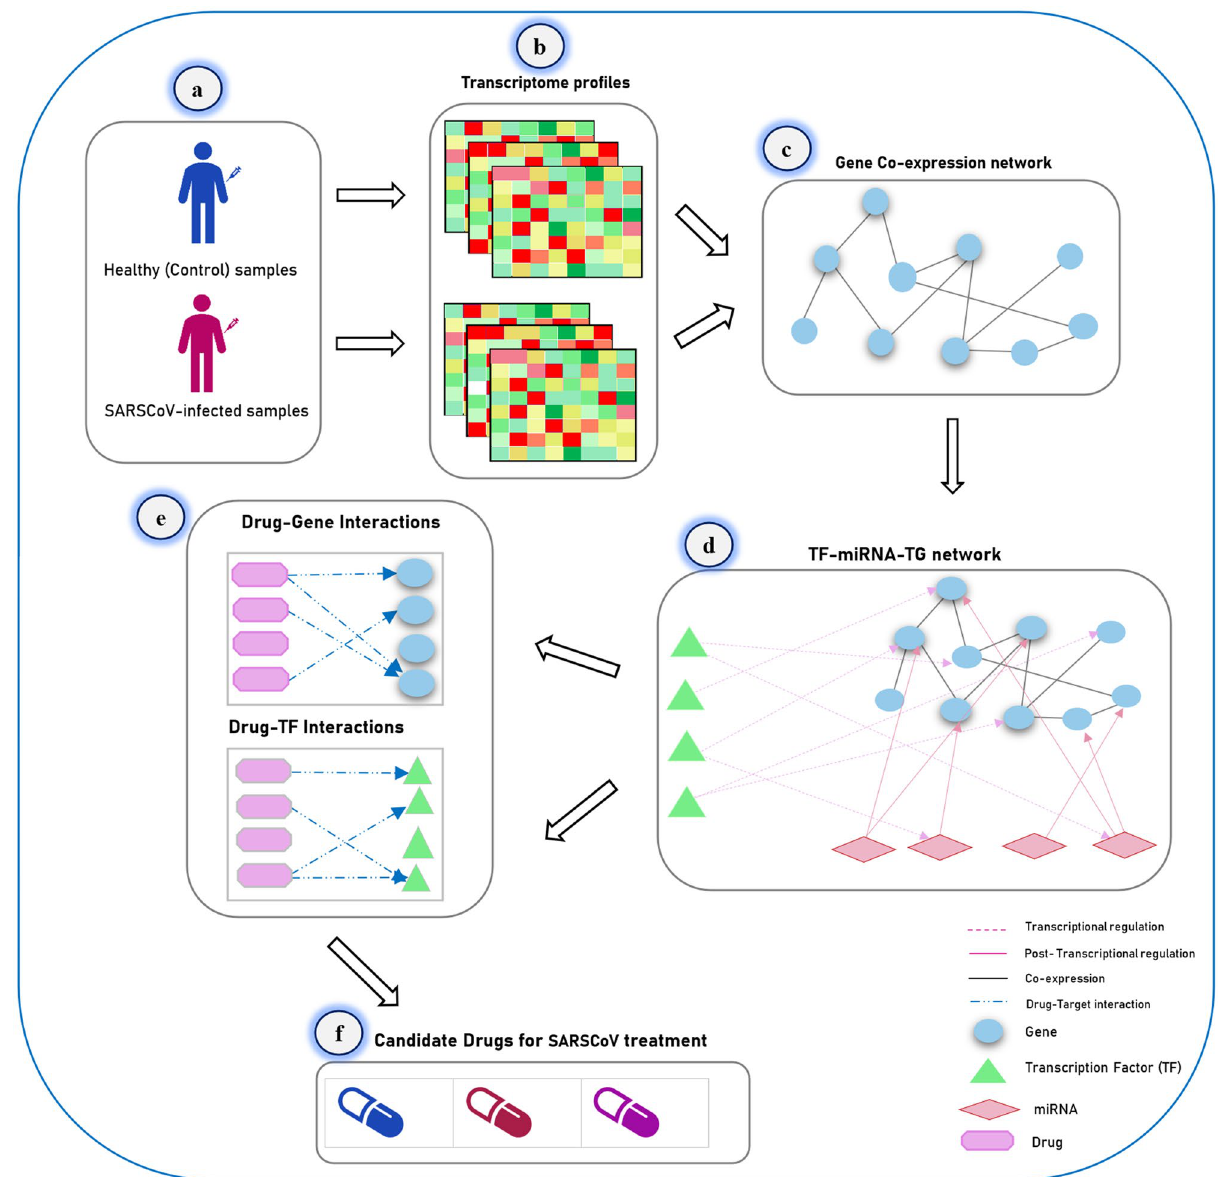
Figure 1. The overall workflow of the proposed method. In this method, a network-based approach is applied to drug repurposing for coronavirus disease treatment. ( a ) At first, a transcriptome profile for healthy (control) and SARS-CoV-infected samples were taken from the GEO database with the accession number GSE1739. ( b ) Then, after identifying differentially expressed genes in the control and disease groups, the gene co-expression network is reconstructed, and two significant gene modules are discovered from the co-expression network. ( c ) Next, for every gene module, the TF-miRNA-TG network is reconstructed independently. The information of TFs-miRNAs, TFs-TGs, and miRNAs-TGs regulations are taken from the TransmiR 42 , TRRUST 39 , and miRWalk 40 databases, respectively. ( d ) Afterward , Drug-gene and Drug-TF networks are reconstructed for TF-miRNA-TG networks independently. ( e ) Finally, 19 drugs are proposed as candidate drugs for coronavirus